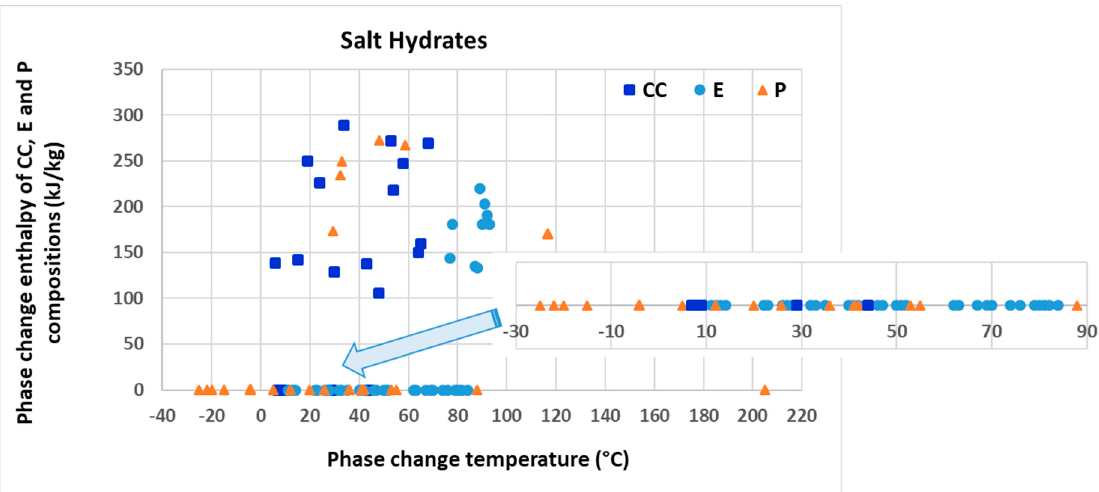
Figure 3. The congruent melting compounds (CC), eutectics (E) and peritectics (P) found within salt hydrates explored over four decades (1977–2016), mapped with phase change enthalpies (shown as zero when the data were unavailable) and temperatures (adapted from [49]).